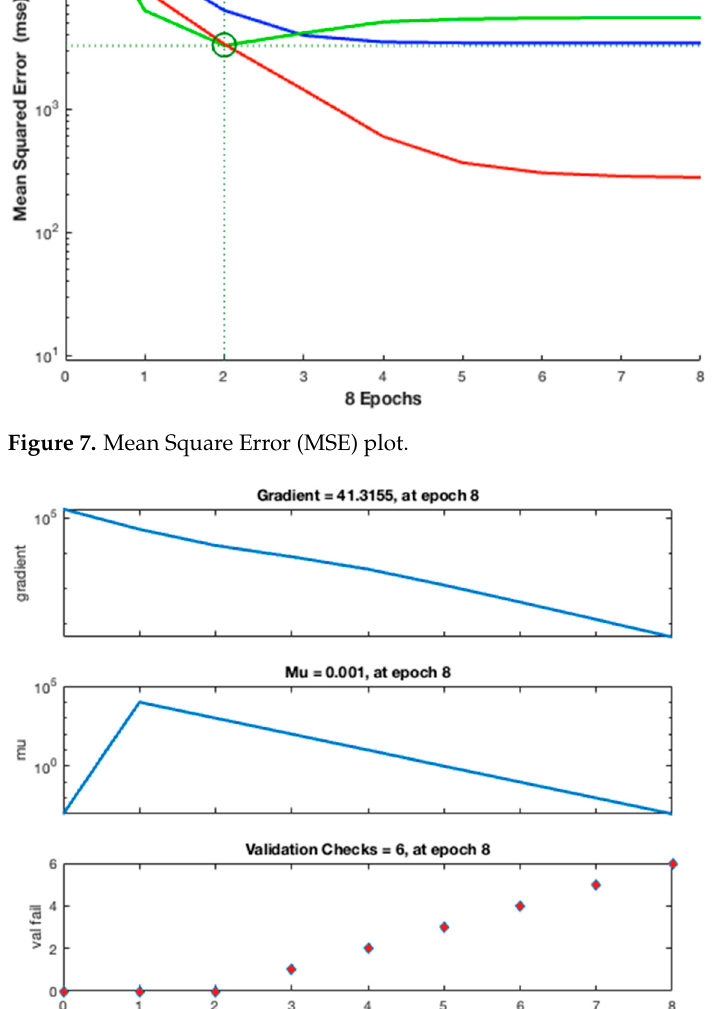
Figure 8. Proposed ANN model training state.